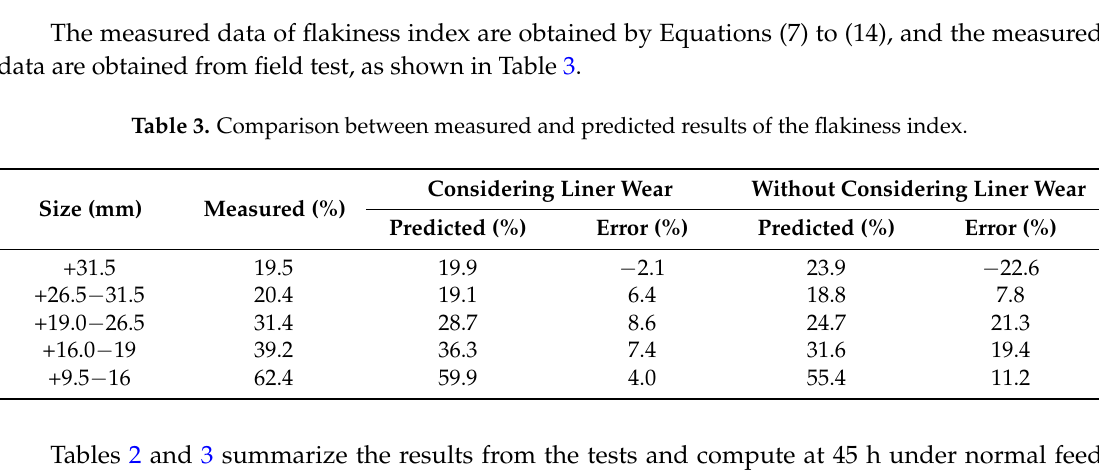
Table 2. Comparison between measured and predicted results of the particle size distribution (PSD).